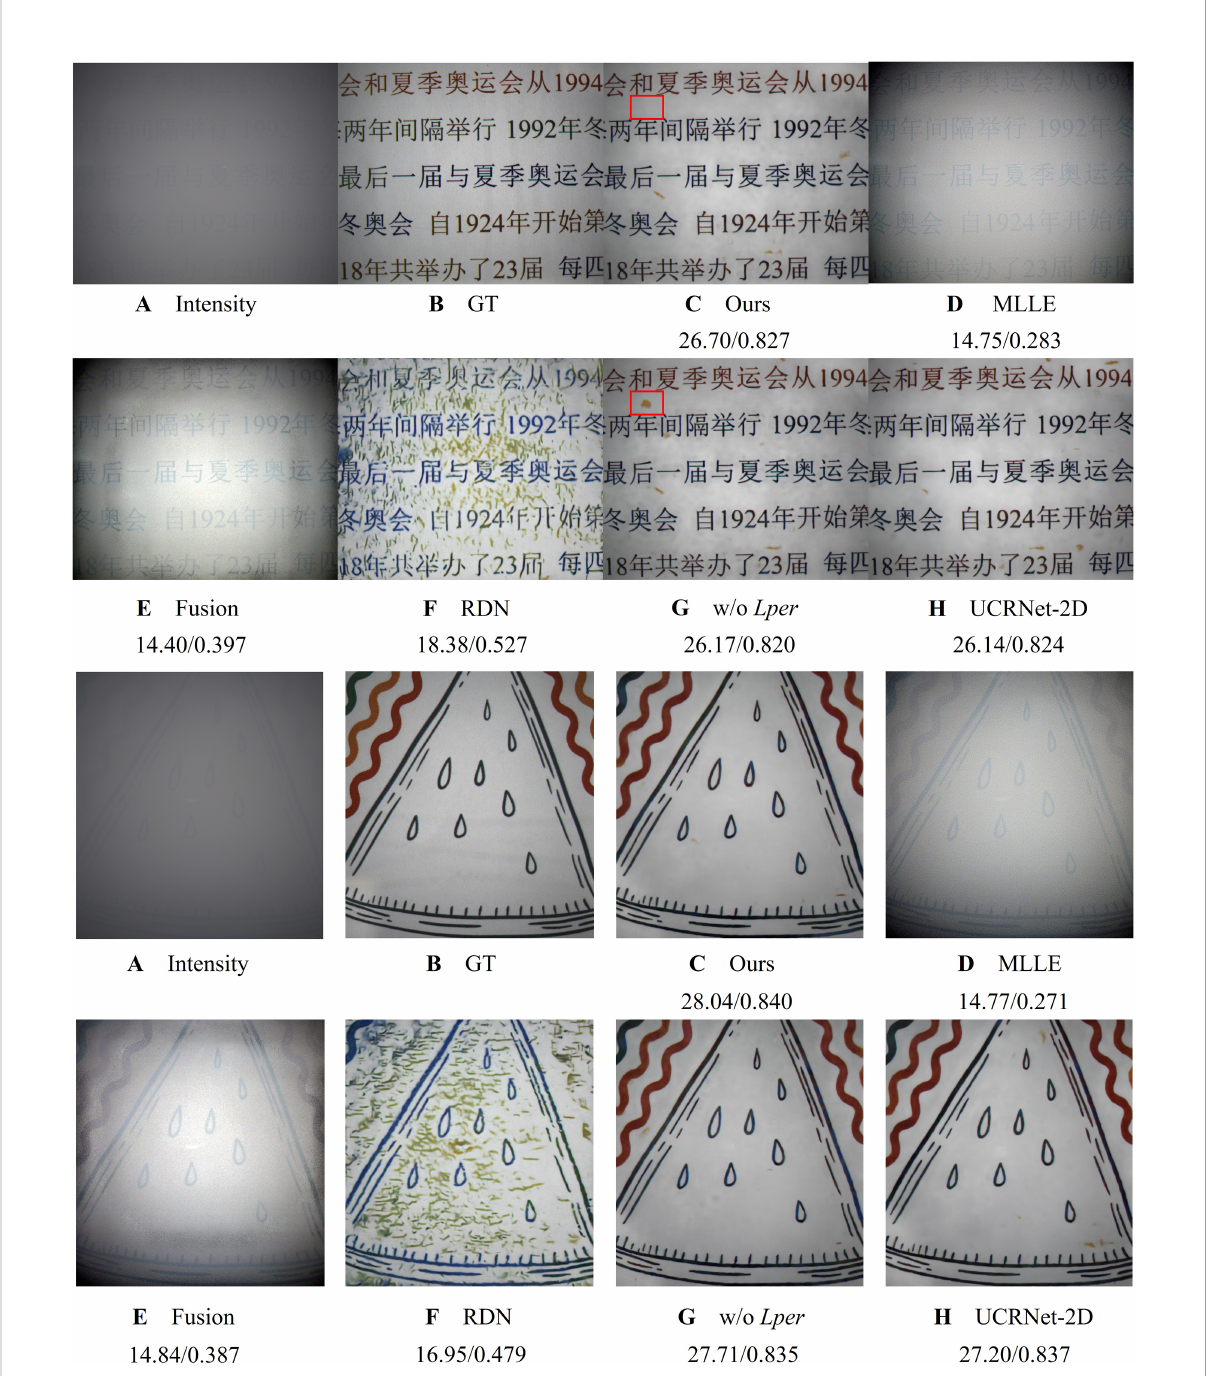
FIGURE 3 Results of the visual comparison. Two evaluation metrics below the image represent PSNR (dB) and SSIM respectively. (A) Intensity; (B) GT; Results by (C) Proposed method, (D) MLLE (E) Fusion, (F) RDN, (G) w/o L per , and (H) UCRNet-2D. (1) and (2) are represented two samples in the test